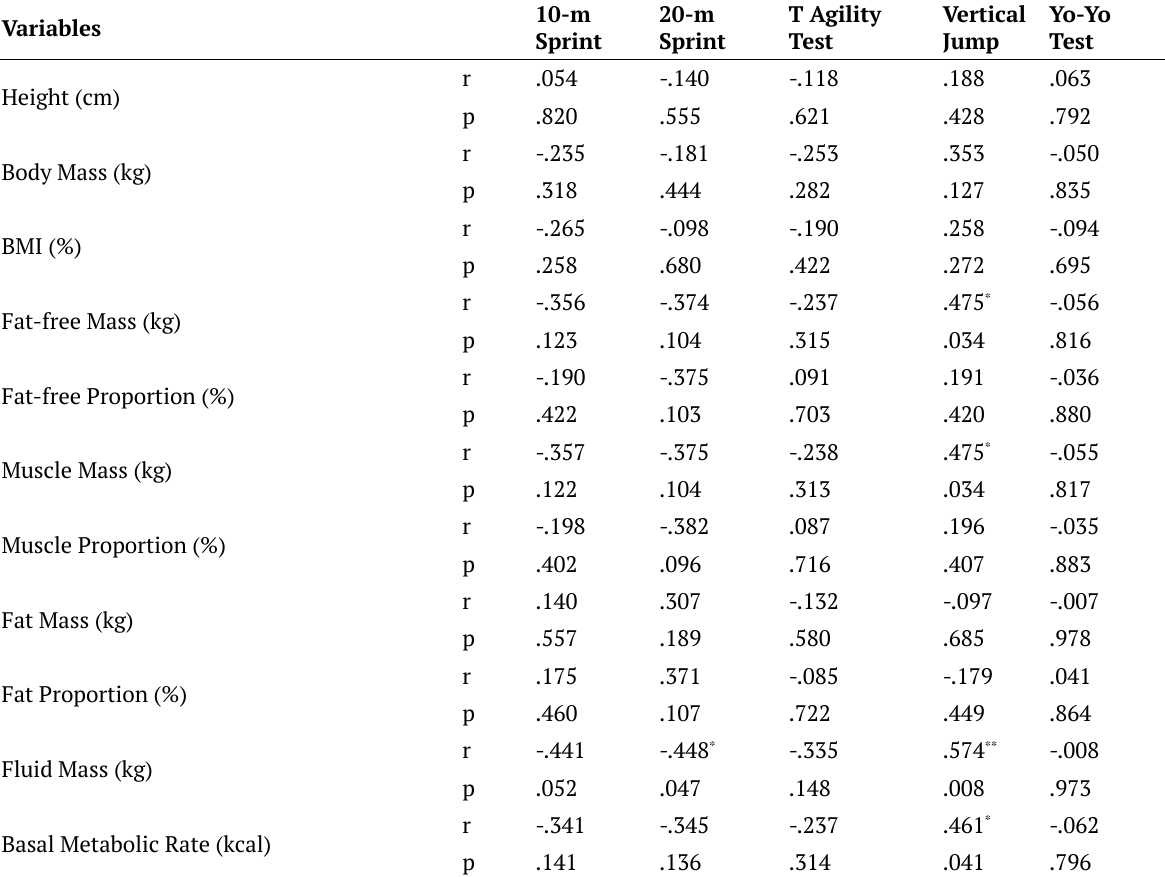
Table 3. Pearson Correlation Test Results for Body Composition and Biomotor Tests (n=20) Variables